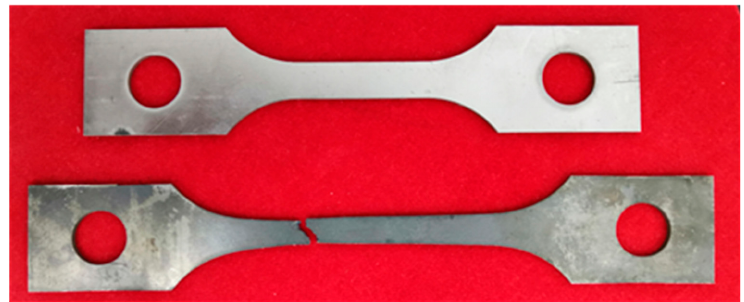
Figure 2. The comparison between original sample and fractured sample of the GH3230 superalloy double-sheet.